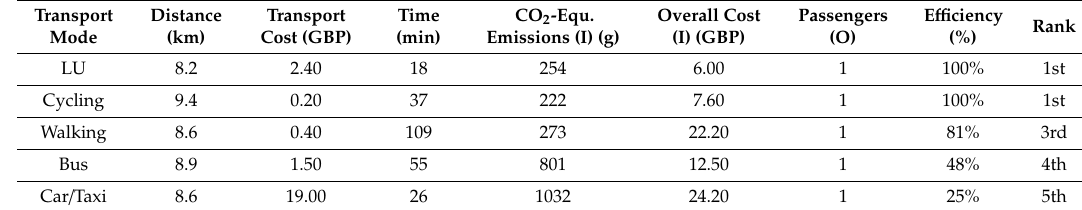
Table 7. Route D. Results in descending order of e ffi ciency of the transport modes DEA model.